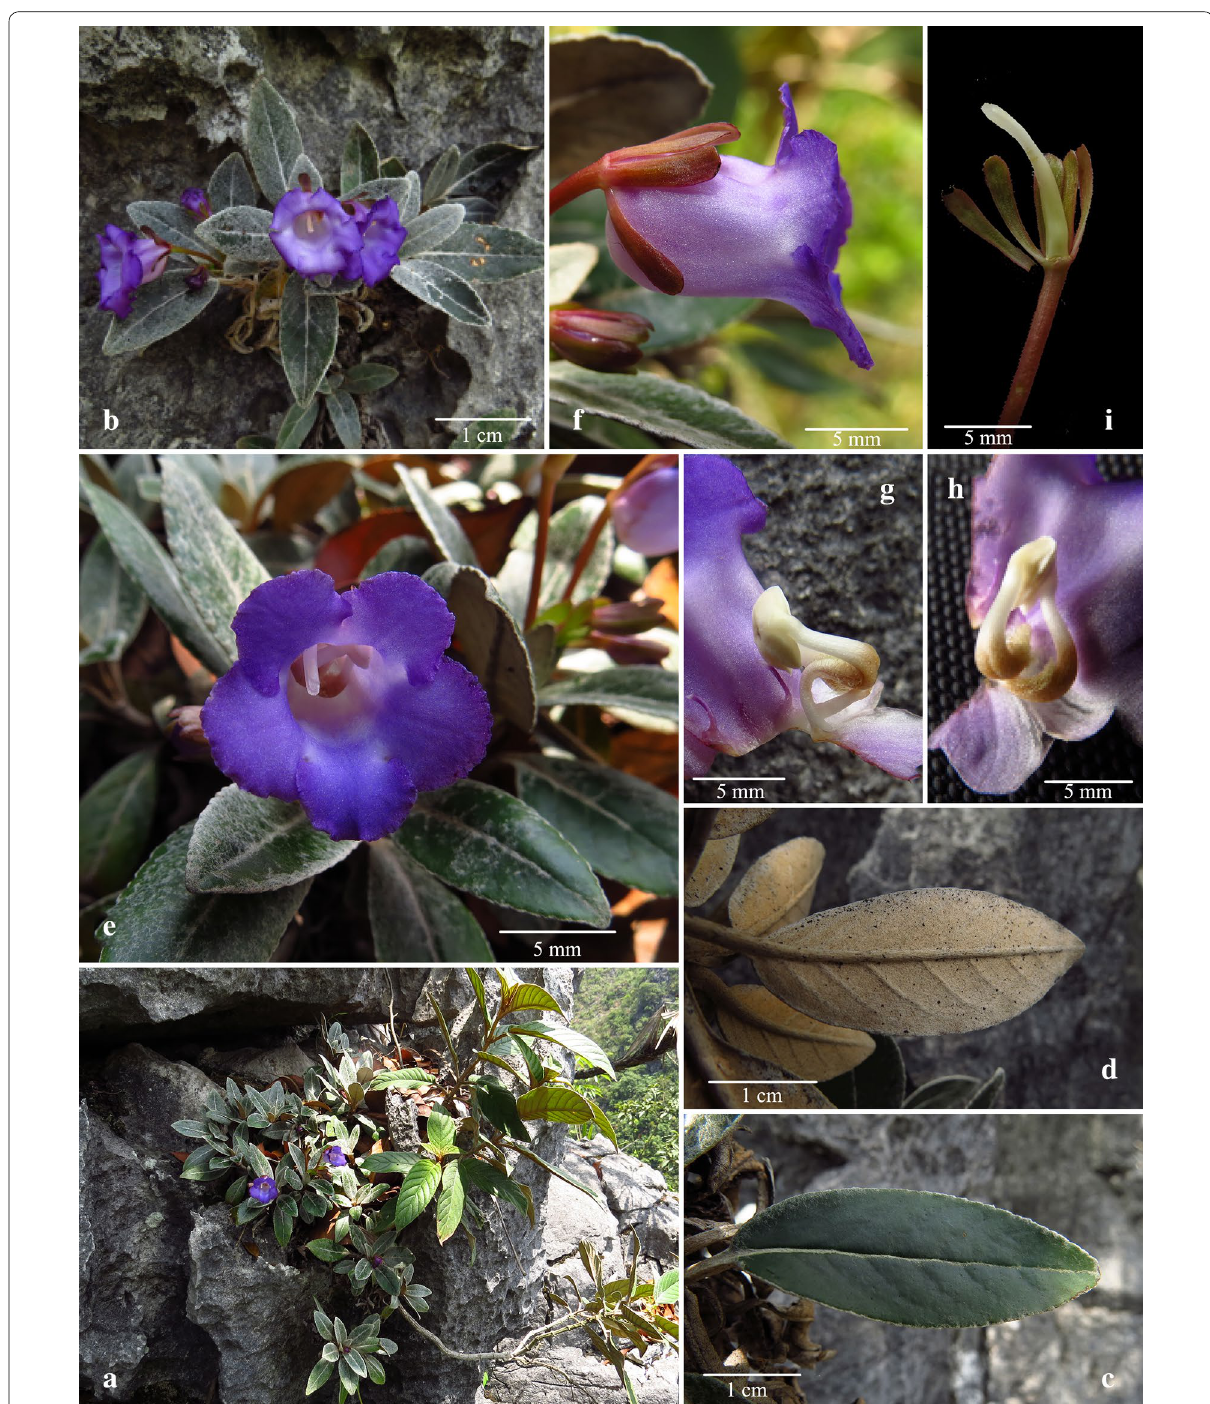
Fig. 5 Paraboea sinovietnamica W.B.Xu & J.Guo. a Habitat; b habit; c upper surface of leaf; d lower surface of leaf; e flowers face view; f flowers side view; g stamens side view; h stamens face view; i pistil and